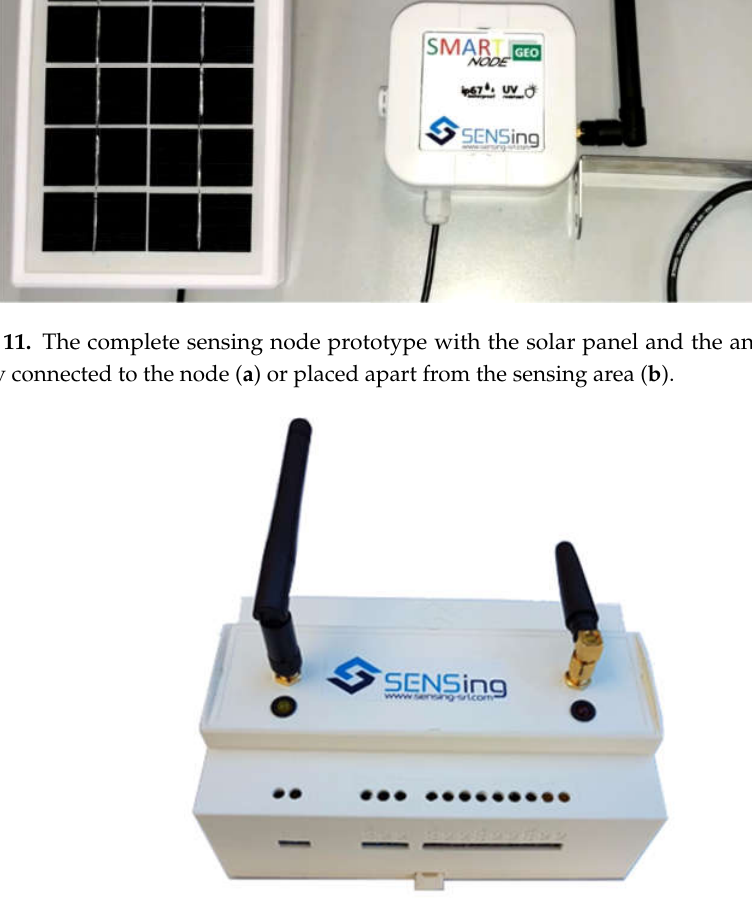
Figure 12. The datalogger protopype (Also for this component external antenna and solar panel can be added).